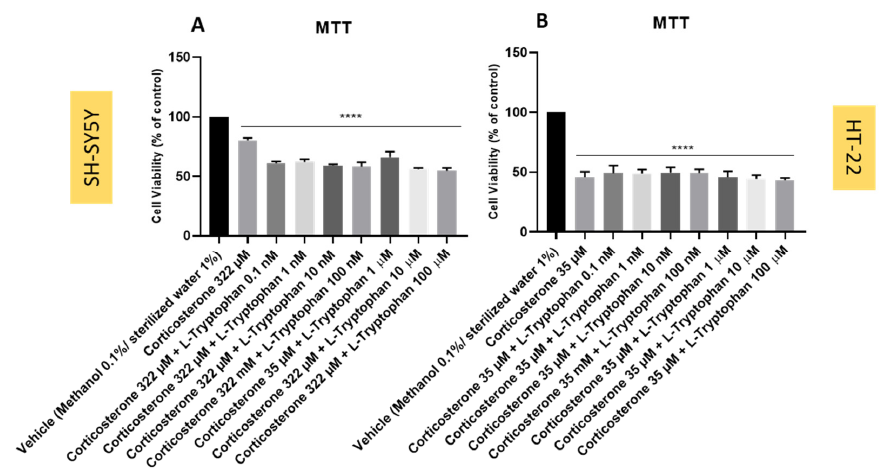
Figure 15. Effect of 48 h-incubation of ( A ) 322 µ M of corticosterone and ( B ) 35 µ M of corticosterone , in combination with 0.1 nM-100 µ M of L-tryptophan, determined by MTT assay. The results represent the mean ± SEM of 3–6 independent experiments, expressed as the percentage of the vehicle (100%). Statistically significant. **** p < 0.0001 vs. vehicle.